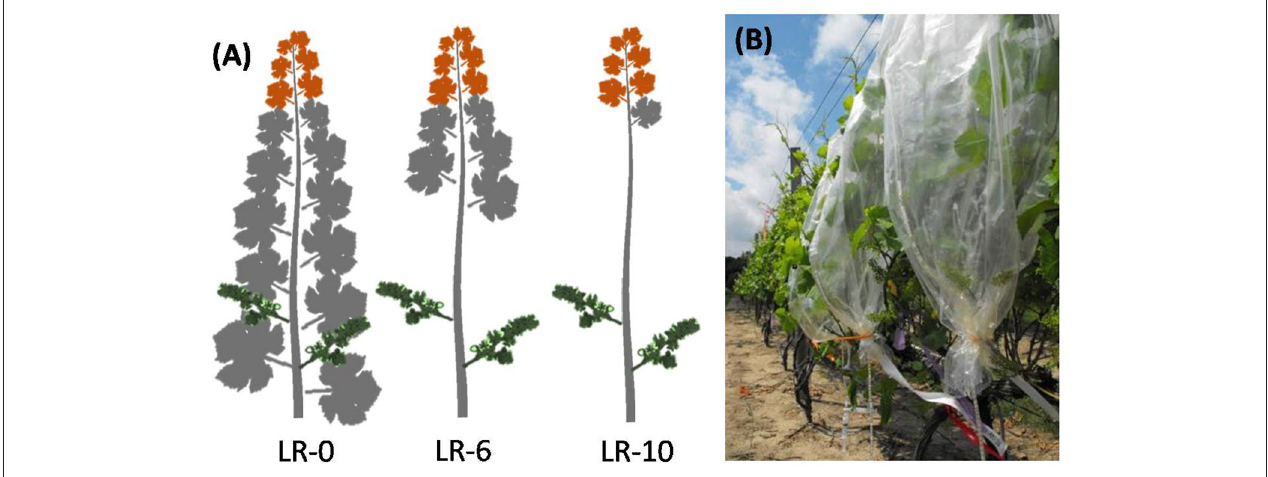
FIGURE 1 | Diagrammatic representation (A) of early leaf removal treatments and of the different organs sampled during the pulsing study:cluster (green), fully expanded leaf (gray), shoot apex (orange). Shoots were enclosed in mylar bags (B) and pulsed for 30min with 13 CO 2, generated by the reaction of 800mg of Ba 13 CO 2 (98 atom %) with 5mL of 85% lactic acid.